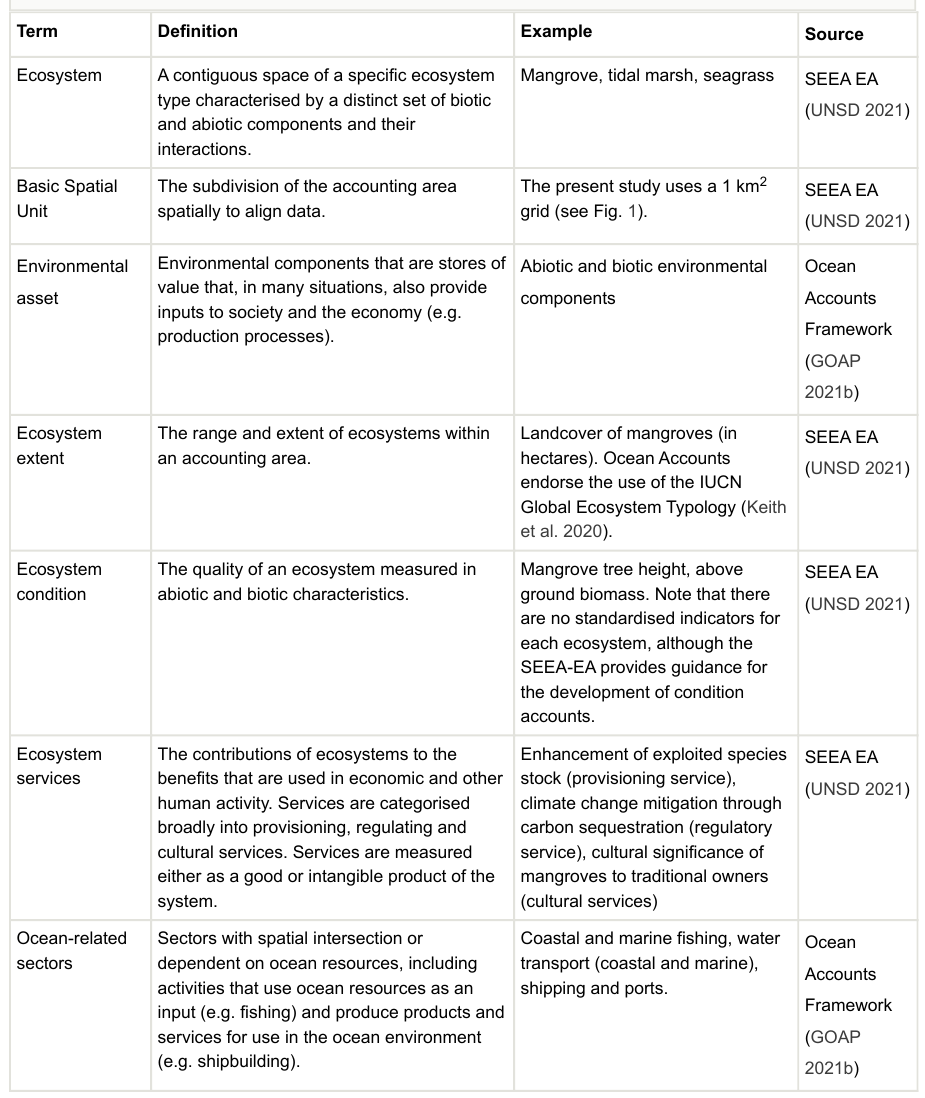
Definitions of terms used within the study, as used within the Ocean Accounting Framework (GOAP 2021b) and aligned with SEEA-EA (UNSD 2021) and SNA (UN 2008) statistical accounting